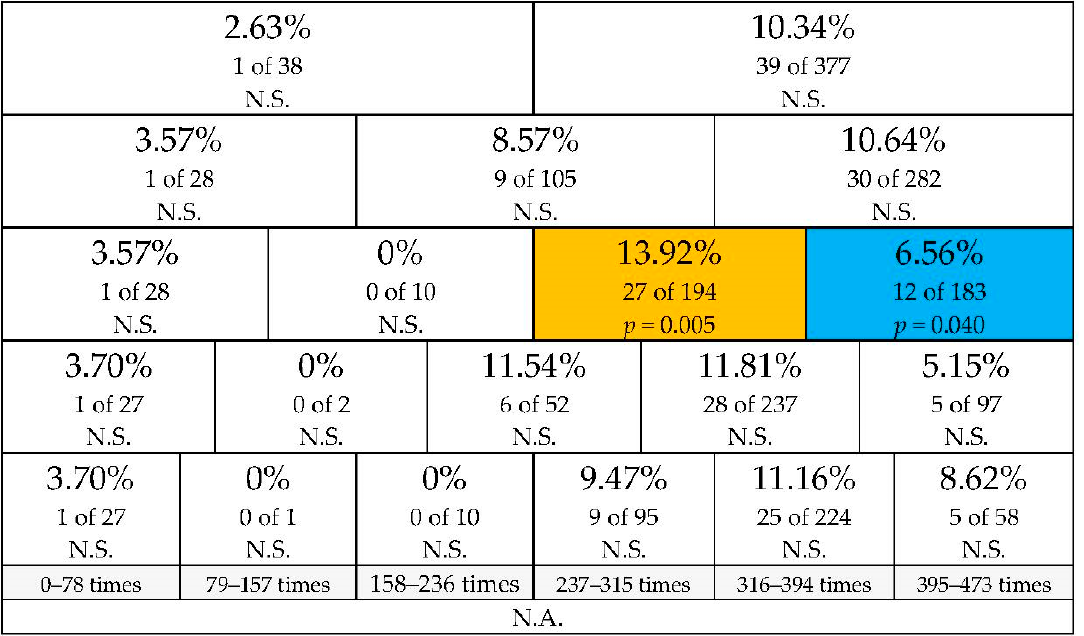
Figure 17. Entrance at yellow effect (analysis 3). This figure shows the results when the frequency in the last 14 days was split in five different ways for the subset: one signal with mean deceleration value of 0.54 m/s 2 . Percentages reflect the percentage of high values in this segment. The numbers below indicate the number of high values and the total. Orange indicates that the percentage is significantly higher than expected and blue indicates a percentage significantly lower than expected. White color indicates no significance. The frequency ranged from 0 to 473. The mean percentage was